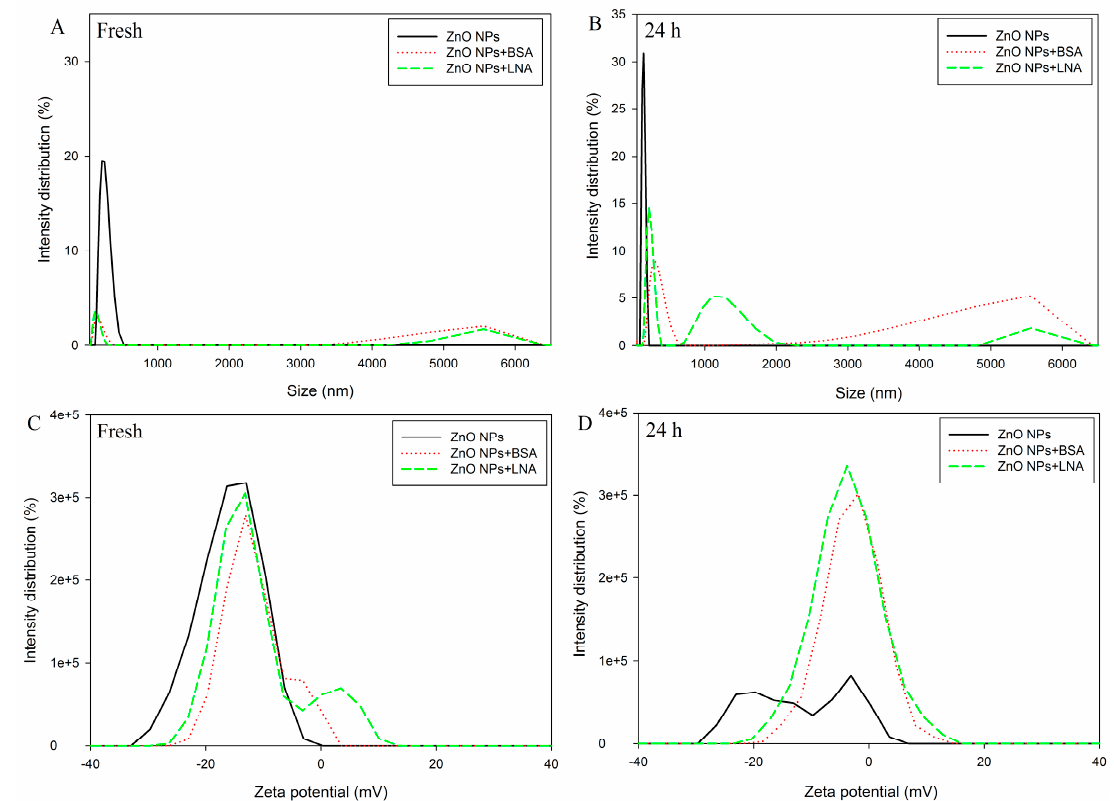
Figure 2. The hydrodynamic size ( A , B ) and zeta potential ( C , D ) of freshly prepared ( A , C ) and aged for 24 h ( B , D ) ZnO NPs (code: XFI06) suspended in distilled and deionized water (DDW), 0.5% BSA, or 200 µM α -linolenic acid (LNA; complexed to BSA; referred as LNA). The sizes smaller than 50 nm are not shown in this figure.